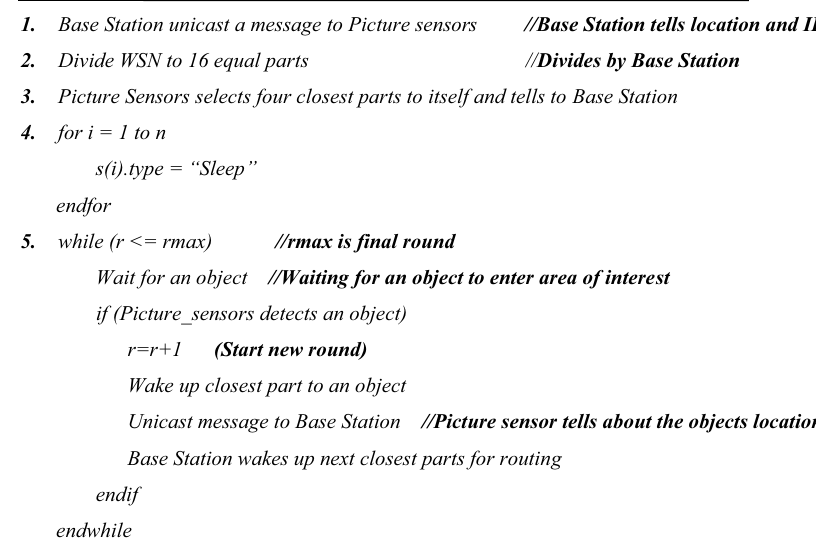
able to transmit its sensed data by means of other parts and through multi-mutation method. Next, clustering is done with the aid of fuzzy logic. By disseminating sound and receiving it, ultrasonic sensors detect the speed and movement direction of the object and inform the base station about it. In case the respective object moves along the borderline of the network, the object will